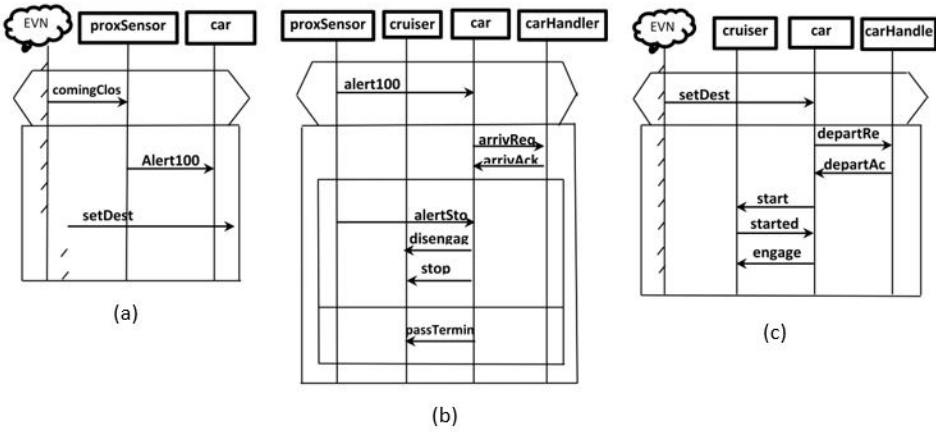
Figure A3. System Specifications of Railcar Case Study in the Form of s-TS . ( a ) Scenario of passenger in terminal (scenario 1). ( b ) Scenario of car approaching terminal (scenario 2). ( c ) Scenario of car departing terminal (scenario